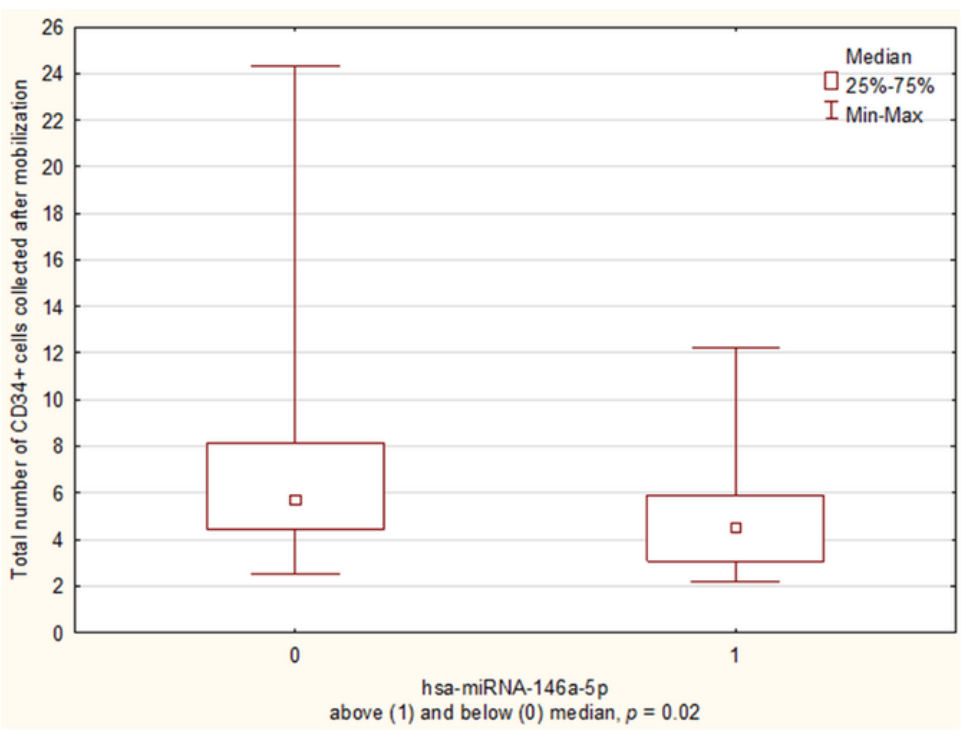
Figure 2. The comparison of the total number of CD34+ cells collected after mobilization at hsa-miR- 146a-5p “low” and “high” expressors on the day of the first apheresis.